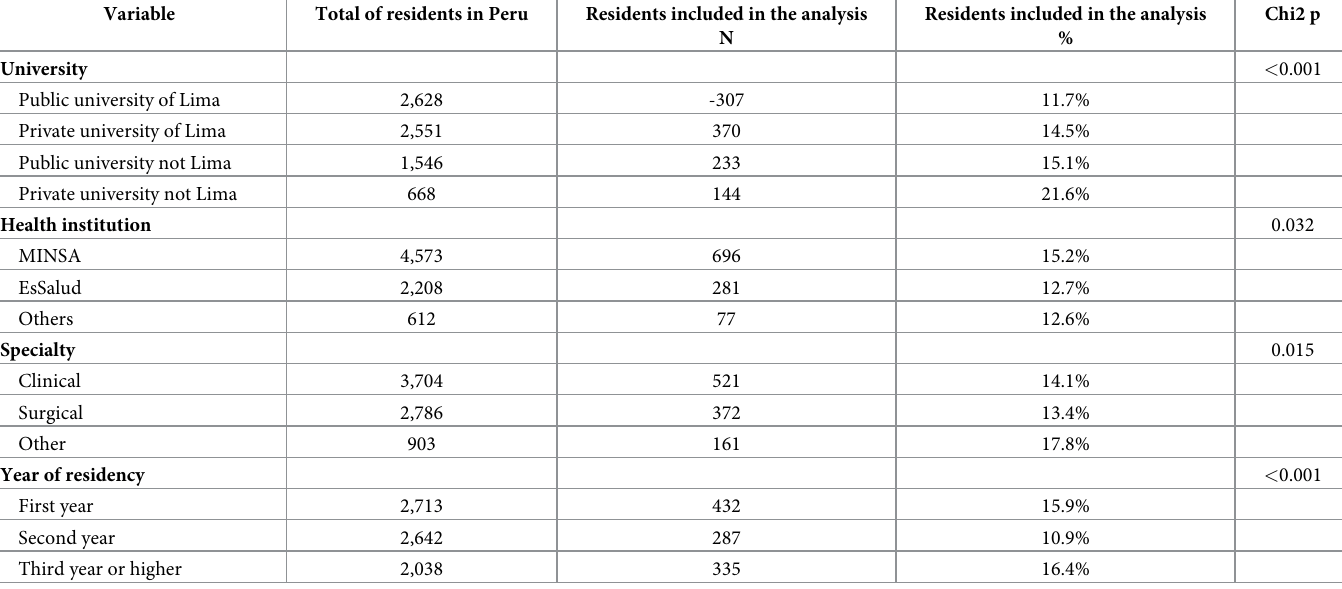
Table 1. Characteristics of Peruvian residents and residents included in the study.